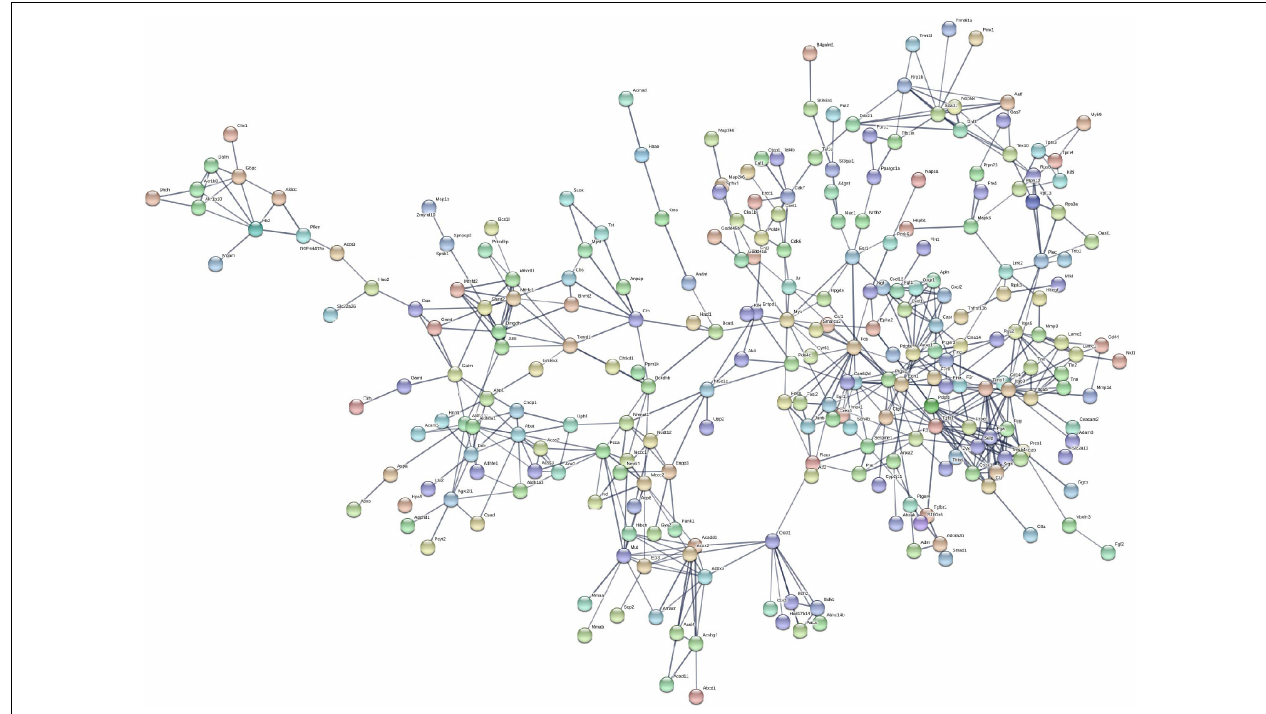
FIGURE 4 | Protein–protein interaction network of the 722 overlapping DEGs with a score > 0.7. Disconnected nodes were hiding in the network. Each node stands for a gene or a protein, and edges represent the interactions between the nodes.